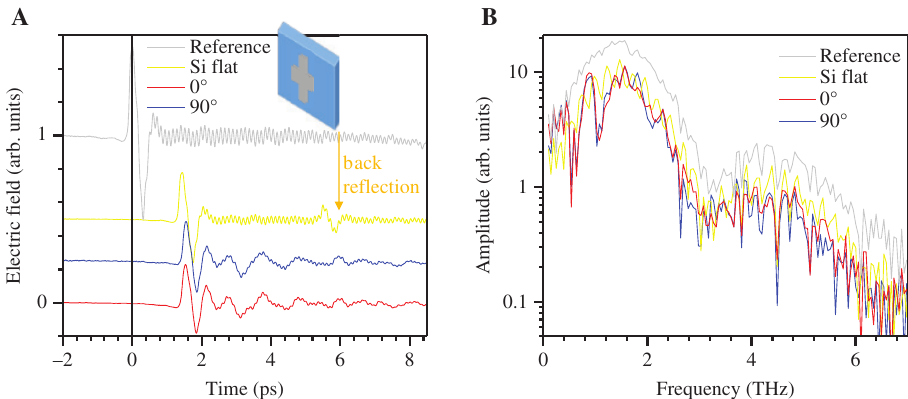
Figure 6: Polarization-independent action of the Si metasurface vortex generator measured by THz time-domain spectroscopy (THz-TDS). (A) Electric field transients (waveforms). Reference is the reflection signal from the GaAs antennae. Back-side reflection is shown on the waveform from the flat Si. Two perpendicular polarizations at 0 ° and 90 ° shows nearly identical waveforms. The high-frequency fringing is the result of the Fabri-Perot etalon made of the front and back surfaces of Si. (B) Fourier transform of the waveforms shown in (A).